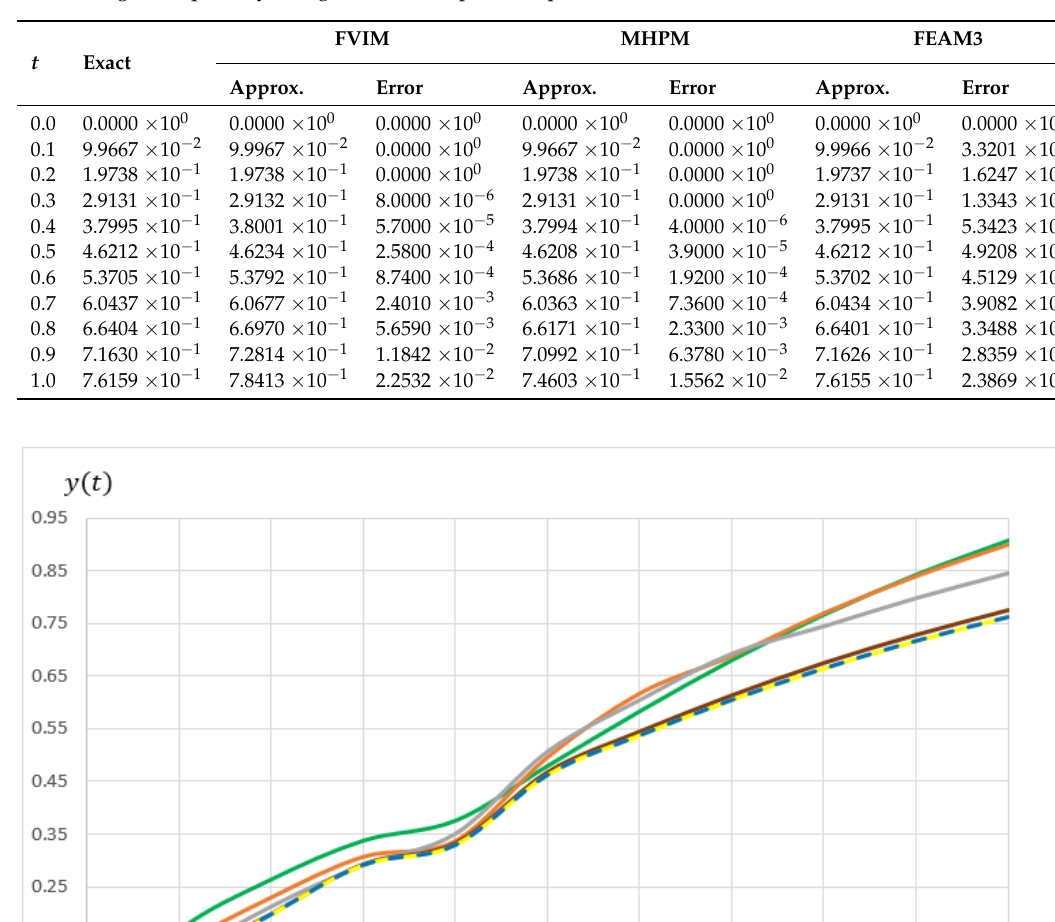
Table 13. Approximate solution and absolute error at each point, t when α = 1.0 with N = 10 in solving Example 6 by using FEAM3 compared to previous methods, FVIM and MHPM.